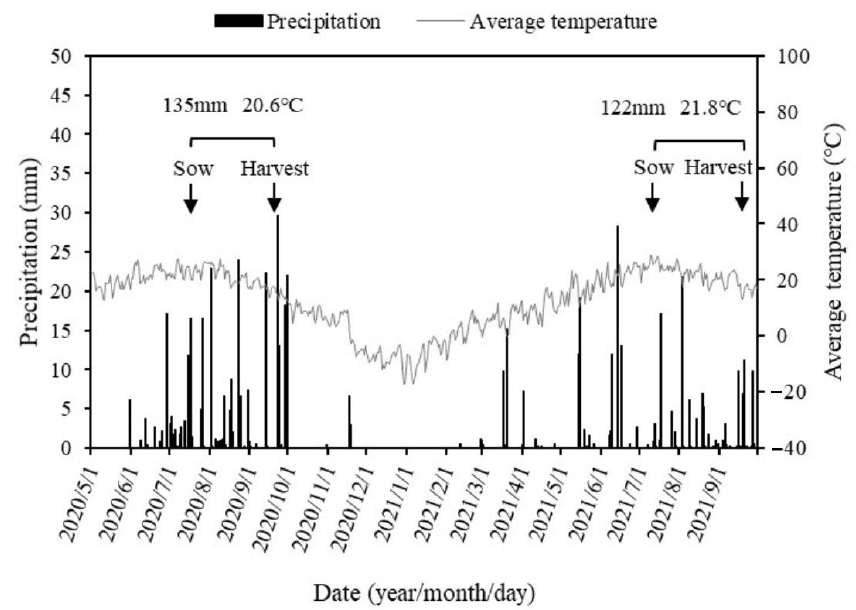
Figure 1. Average temperature and precipitation at the site during the growing seasons in 2020 and 2021. The upper part of the figure shows the average temperature and total precipitation during the growing period from sowing to harvest in both years.